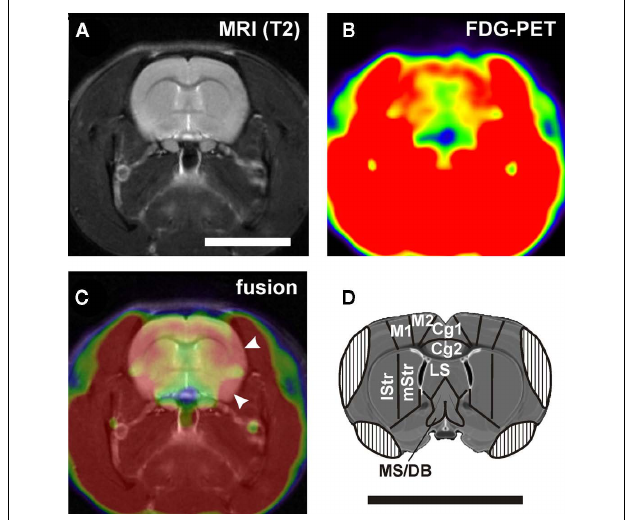
FIGURE 2 | (A) Example of a structural MRI and (B) the corresponding PET image. (C) Fusion of the two images shows muscle artifacts on the lateral aspects of the brain (arrowheads).This leads to covering of the lateral cortical regions in the atlas (D) . Cg1, Cg2, anterior cingulate cortex area 1 and 2; LS, lateral septum; lStr, dorsolateral striatum; M1, motor cortex; M2, premotor cortex; MS/DB, medial septum and diagonal band of Broca; mStr, mediodorsal striatum. Scale bars: